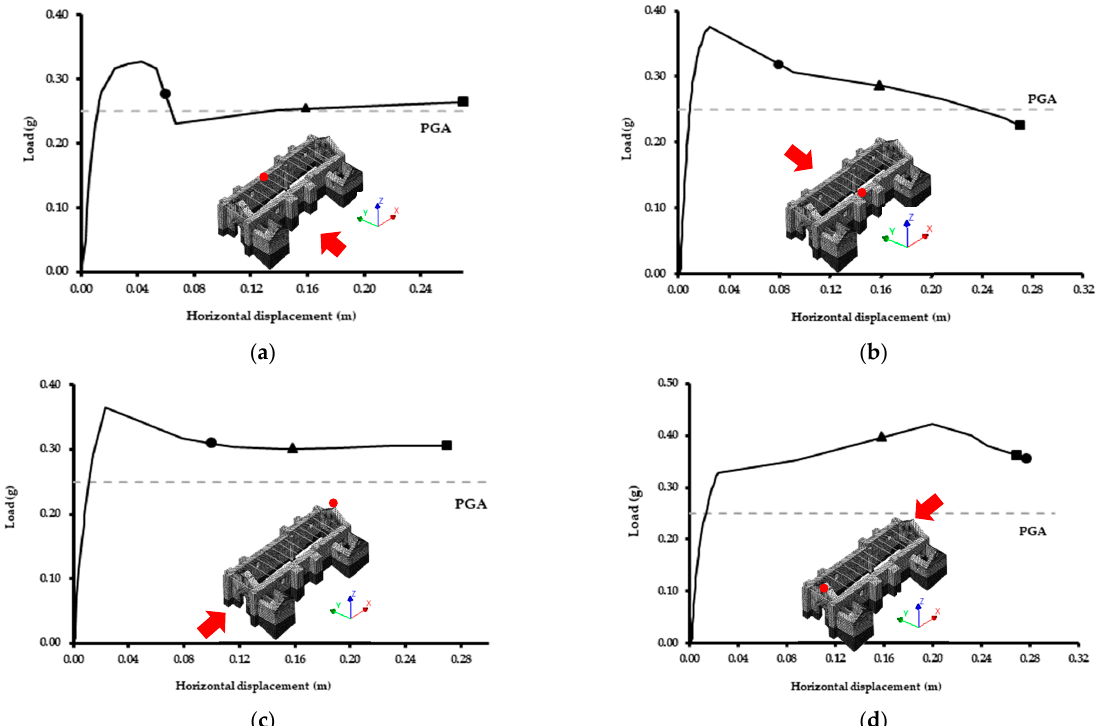
Figure 20. Pushover curves in different directions: ( a ) +YY, ( b ) − YY, ( c ) +XX and ( d ) − XX. Here, the representative points for the ASCE41-13 ( ∎ ), NTC 2018 ( ● ) and KADET 2021( ▲ ) are presented.